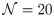
A schematic illustration of the random walk strategy as defined in Eq (1).In (a) we depict N=20 random locations on the plane (represented by stars); the probability to go from location a to a different site is determined by two types of transition probabilities: First, to a site b inside a circular region of radius R centered in the location a, wa→b(α)(R), which is a constant; and second, a transition to a site c outside the circle of radius R, wa→c(α)(R) that considers long-range transitions with a power-law decay proportional to lac-α, where lac is the distance between sites a and c. In (b) we show Monte Carlo simulations of a discrete-time random walker that visits N=100 specific locations in the region [0, 1] × [0, 1] in R2 following the random strategy defined by the transition probabilities in Eq (1), with R = 0.17. We depict the results for a short-range dynamics with very large values of the exponent (α → ∞), and a long-range dynamics with α = 5. The total number of steps is t = 200 and the scale in the color bar represents the time at each step.